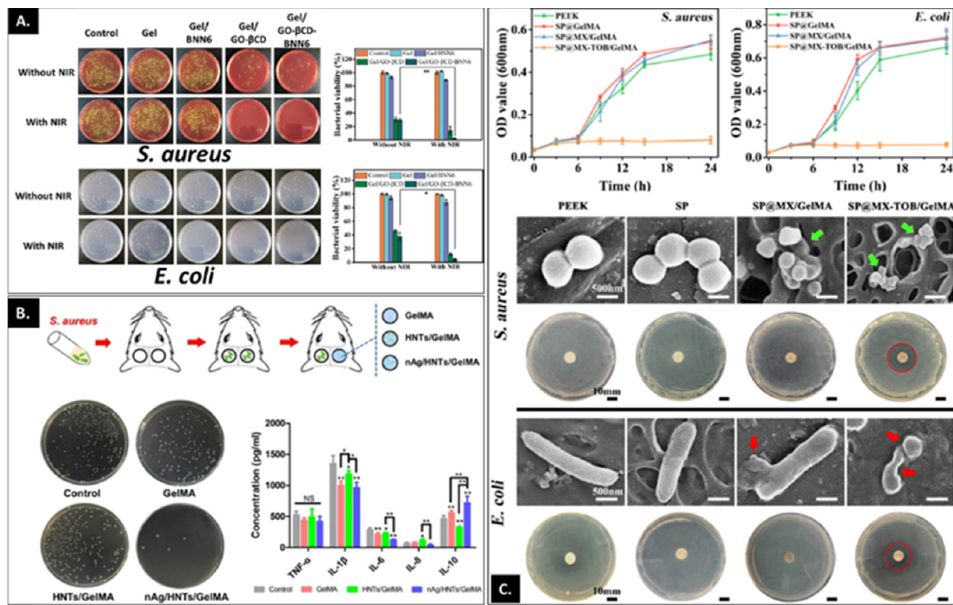
Figure 4. ( A ) Antibacterial activity of different substrates on agar plates and corresponding colony forming units (CFUs) against S. aureus and E. coli with or without near infra-red radiation laser at 808 nm; laser density, 1.5 W/cm 2 for 10 min. n = 3; error bars indicate standard deviation,